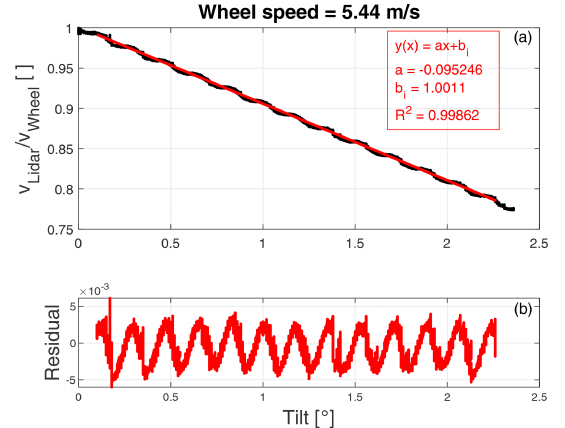
Figure 13. Example of calibration measurement made with a refer- ence speed of 5.44ms − 1 and a focus distance of 1.53m. The black curve indicates the measurement data and the red curve indicates a least-squares fit of a straight line to the data. Panel (b) shows the residuals of the fit showing some distinct oscillations because of the speed estimation jumping from bin to bin due to the very narrow beam.